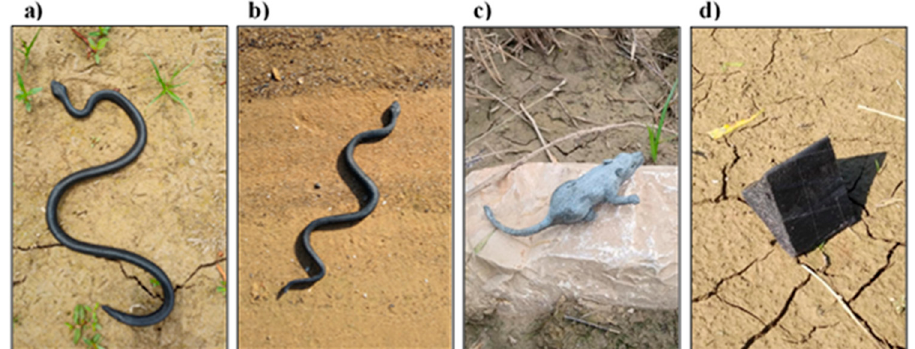
Figure 2. Urethane foam prey models: ( a ) large-sized snake mimic (45.72 cm length × 5.08 cm diam- eter); ( b ) small-sized snake mimic (20.32 cm length × 2.54 cm diameter); ( c ) mouse mimic (8.89 cm length (not including tail) × 6.35 cm diameter in the midsection); ( d ) triangular control (7.62 cm height × 12.7 cm base x 10.16 cm width).